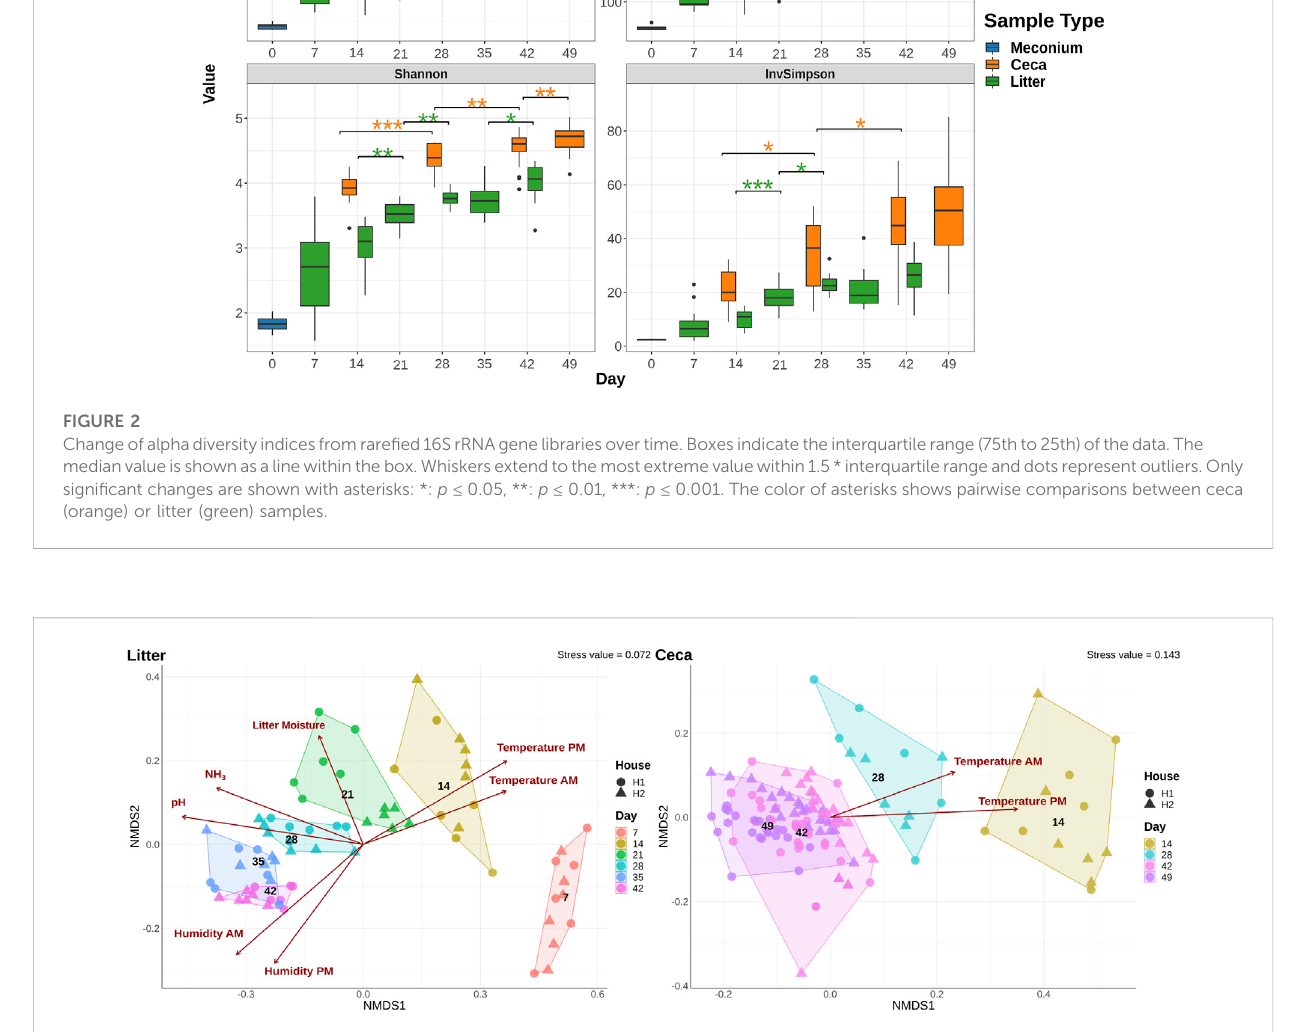
Shifts of microbial community composition in cecal and litter samples. Beta diversity was calculated using a non-metric multidimensional scaling (NMDS) ordination of 16S rRNA gene libraries based on Bray-Curtis distances. Colors show samples obtained on different days and the shape displays samples from different houses. Only signi fi cant ( p < 0.05) environmental variables were fi tted onto the